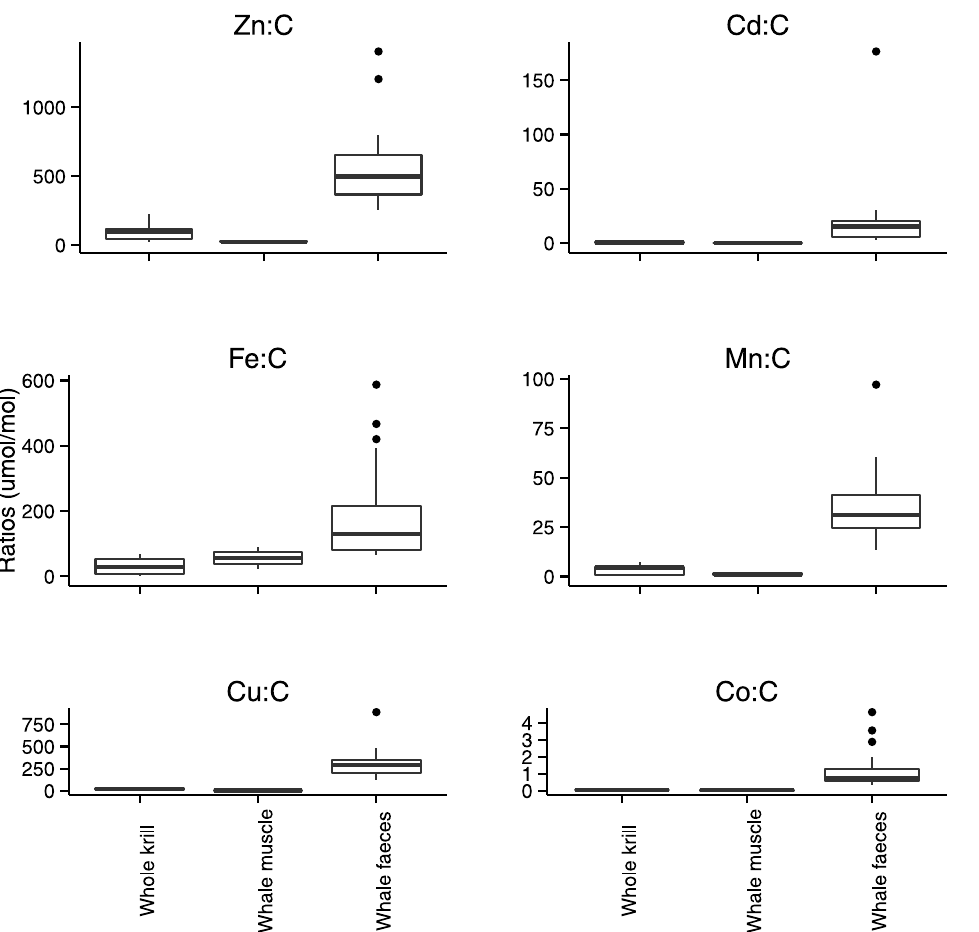
Figure 1. Metal to carbon ratios in krill and whales ( m mol mol 2 1 ). Data points above the third quartile for whale faeces are 3 or more times higher than the interquartile